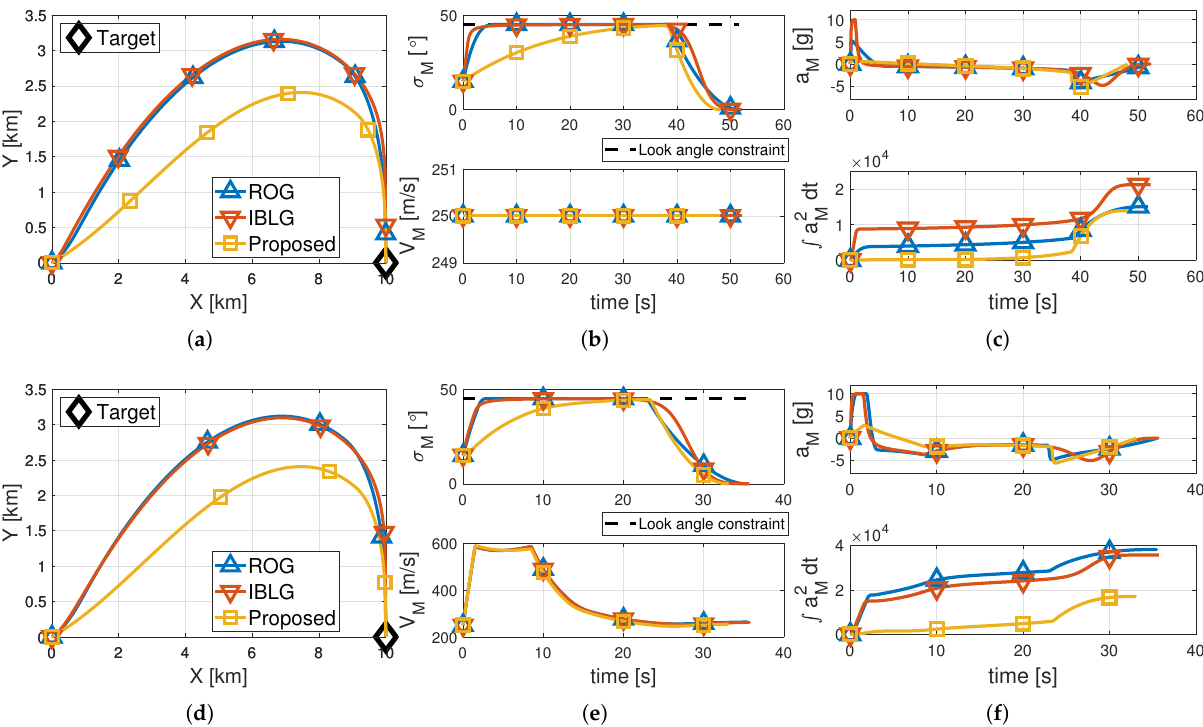
Figure 4. Simulation results of ROG, IBLG, and the proposed law in ideal ( a – c ) and realistic ( d – f ) scenarios. ( a ) Flight trajectories. ( b ) Look angles and speeds. ( c ) Normal accelerations and quadratic sums. ( d ) Flight trajectories. ( e ) Look angles and speeds. ( f ) Normal accelerations and quadratic